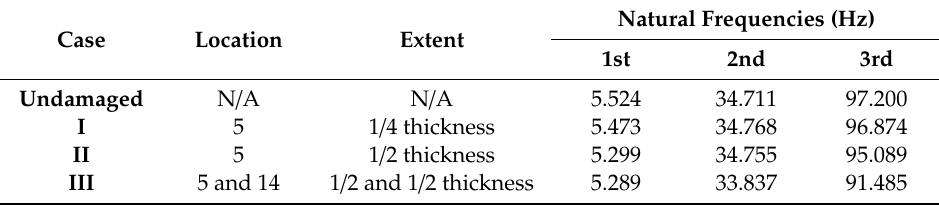
Table 4. Simulated damage cases and measured natural frequencies in the experiment.